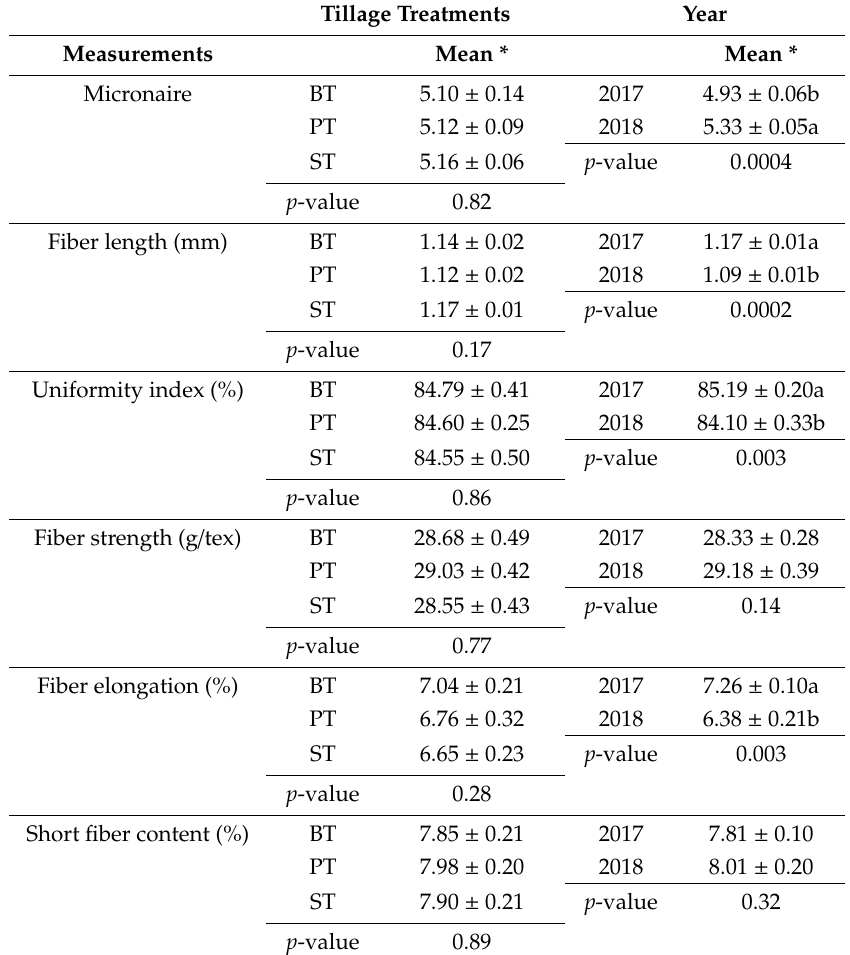
Table 3. Fiber quality parameters of cotton under the tillage treatments in Las Cruces (2017 and